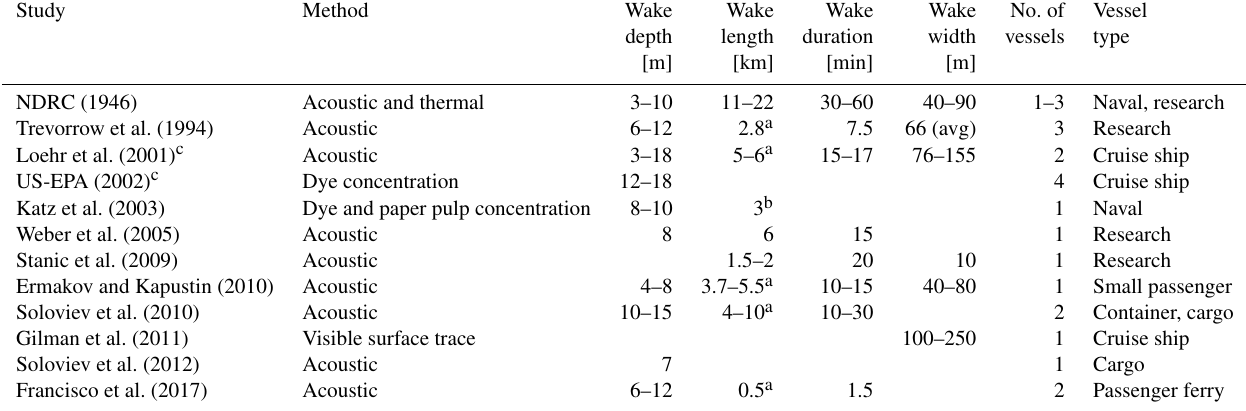
Table 1. Previously reported field measurements of the spatial and temporal scales of the turbulent wake. The method used to estimate the turbulent wake is indicated, as well as the type and number of vessels observed. For studies where only the temporal wake longevity was measured, an estimate of the wake length has been calculated using the wake duration and a ship speed of 12kn.